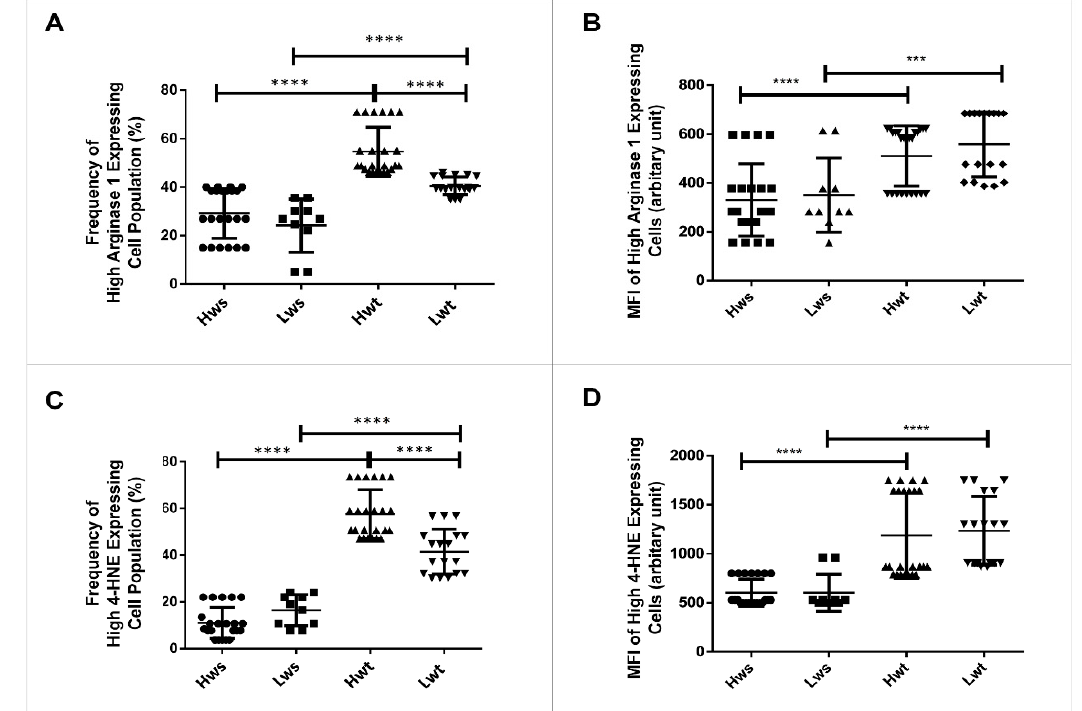
Figure 4. Measurement of the frequency and MFI (mean fluorescent intensity) of high-expressing Arginase1 and 4-HNE in the arterial cord RBCs. The graphical representation in the panels ( A , B ) and ( C , D ) indicate the frequency and MFI of high expressing Arginase1 and 4-HNE RBC population in the mature twin neonates compared to their matched singletons. The statistical significance was accepted at *** p < 0.001 and **** p < 0.0001 based on one-way ANOVA using the Newman-Keuls multiple comparison test.